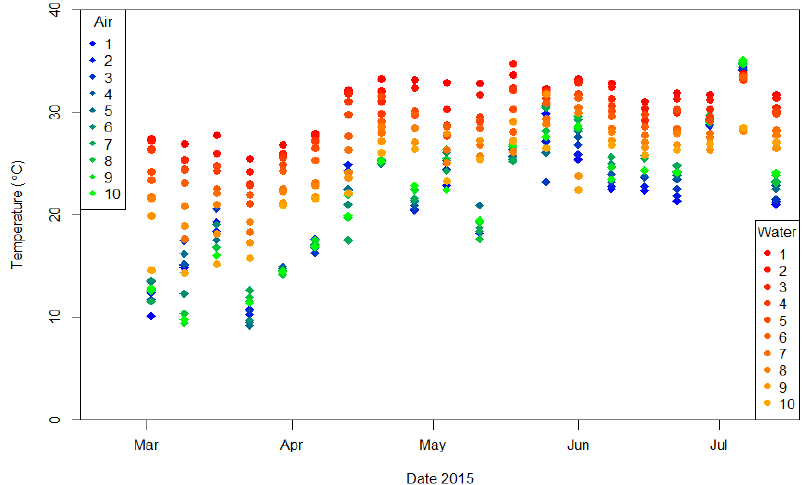
Figure 4. Air temperature 1.5 m above the water surface and water temperature at 10 cm depth at 10 permanent sampling points along thermal stream Topla measured weekly from March to July 2015.